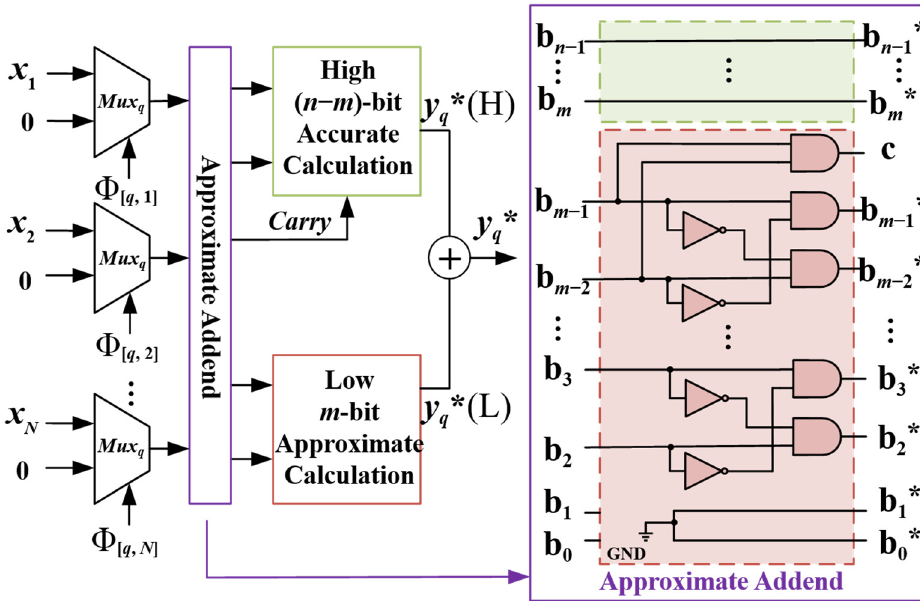
Figure 4. The approximate addition calculation.